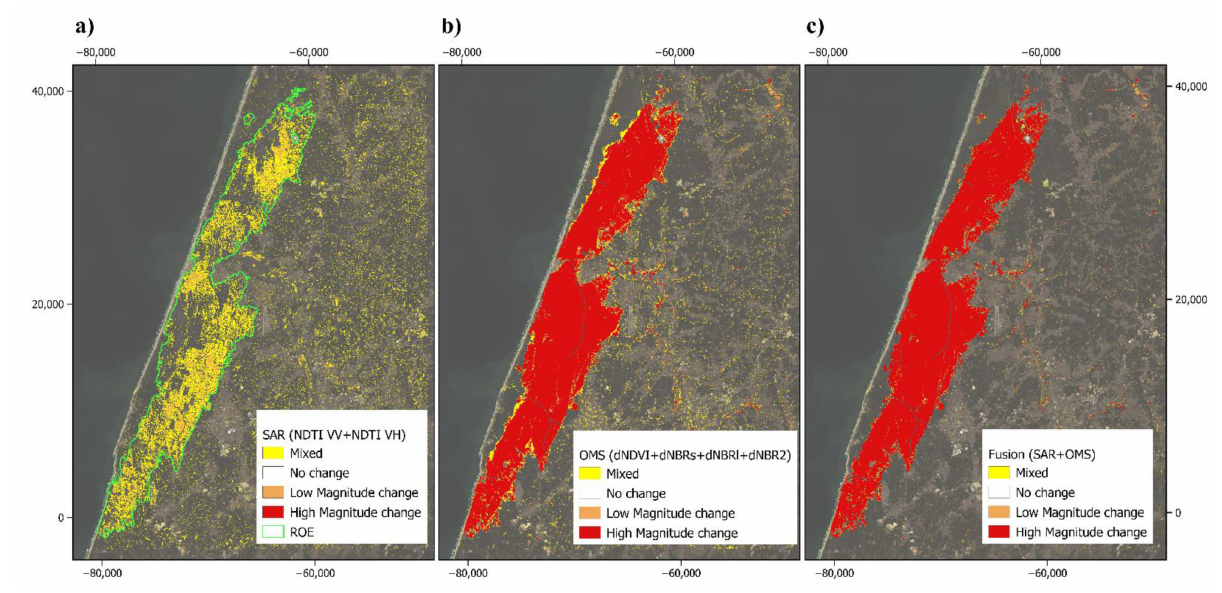
Figure 13. Burned-related change maps for the Leiria National Forest case study obtained from ( a ) the OMS, ( b ) SAR, and ( c ) fusion datasets, in comparison to the Reference Observed Event (ROE) [48] (coordinate reference system: PT-TM06/ETRS89).